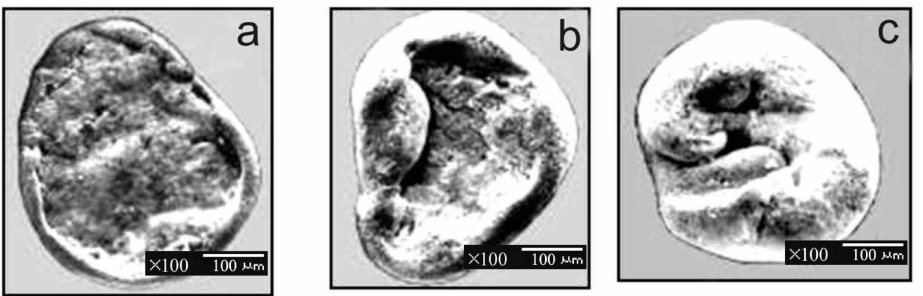
Figure 3. Sequential change of the flaking gold in the course of the experiment: ( a ) the appearance of a thin ridge along the edge of the scaly gold particle; ( b ) the flake’s formation with a well-defined ridge toroidal shape; ( c ) forming a hollow ball.